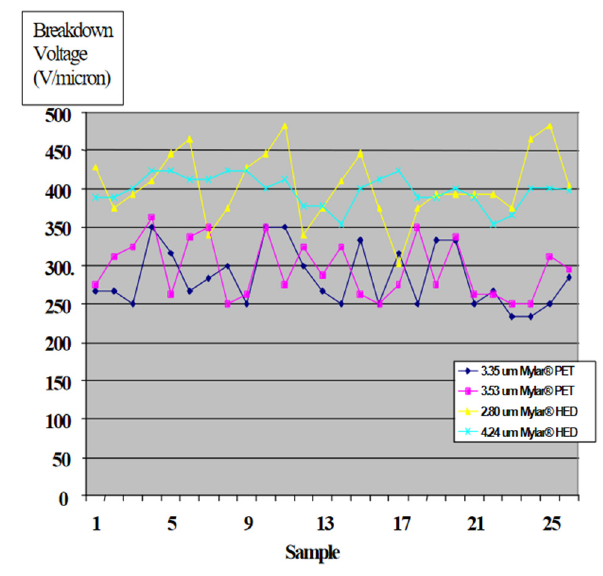
Figure 8. Breakdown data for thin 2-3 µ polymer films [53].